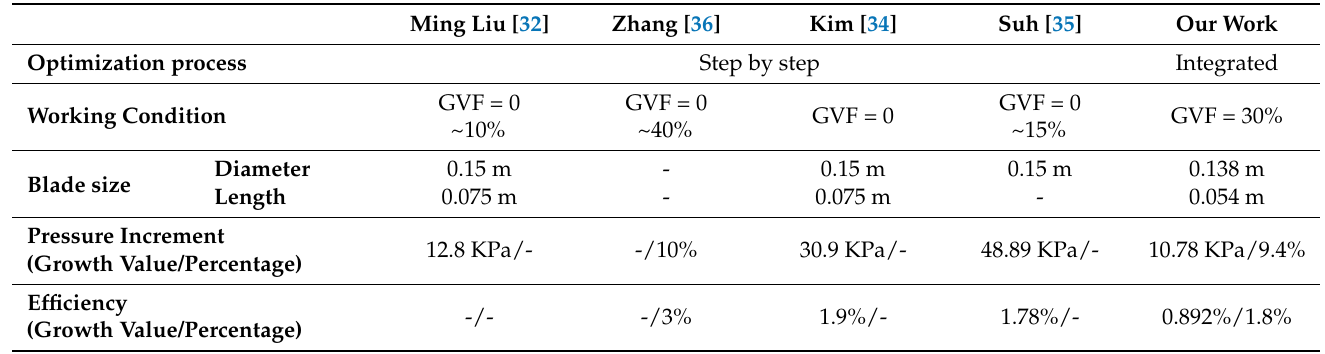
Table 6. A comparison of our work and similar works.